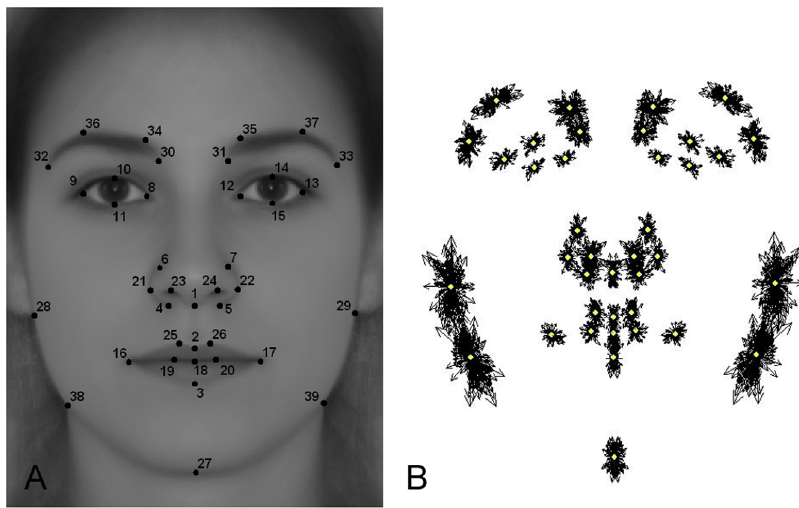
Figure 1. Employed landmarks. A) An average face generated with the complete female population (n=74) and the 39 landmarks placed. B) All 147 subjects’ landmarks configurations superimposed after Procrustes